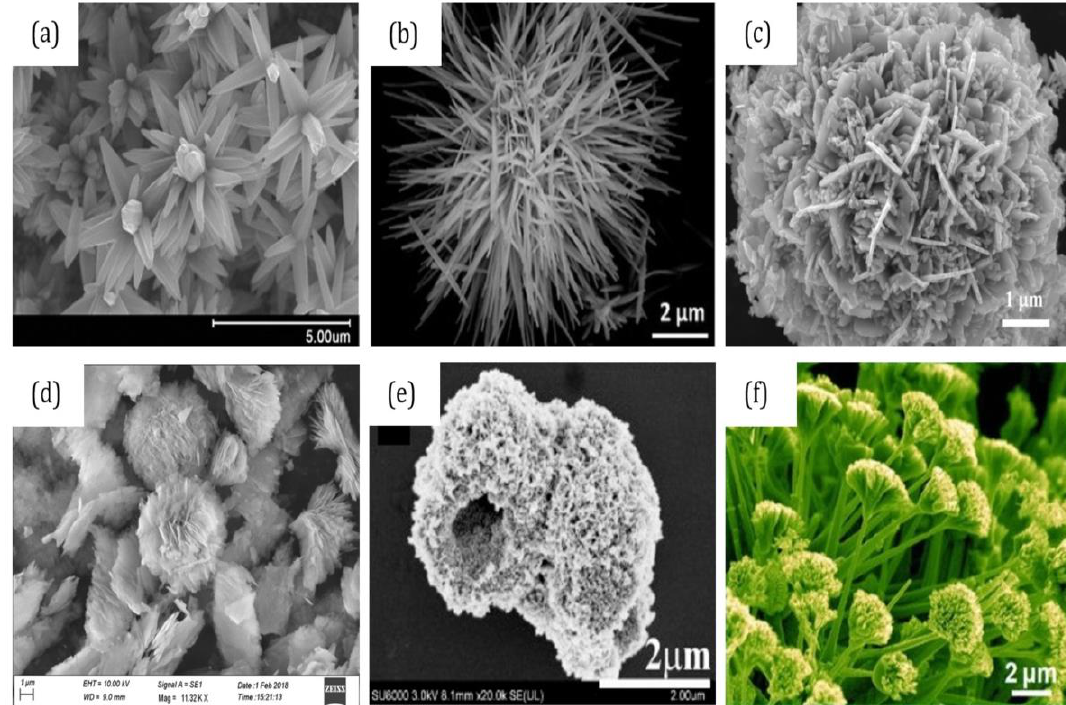
Figure 17. ( a , b ) 1-D as the building unit of 3-D ZnO [134,135]; ( c , d ) 2-D as the building unit of ZnO [136,137]; ( e ) hollow sphere [138]; ( f ) nanoflower grown on an alumina substrate [139].